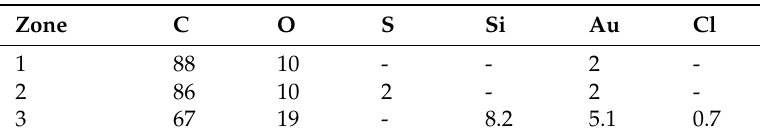
( b ) Figure 12. SEM of the laminate with the coPES/5% POSS veil dissolved in it: ( a ) low resolution (4000×, sx) and ( b ) high resolution (60,000×, dx).